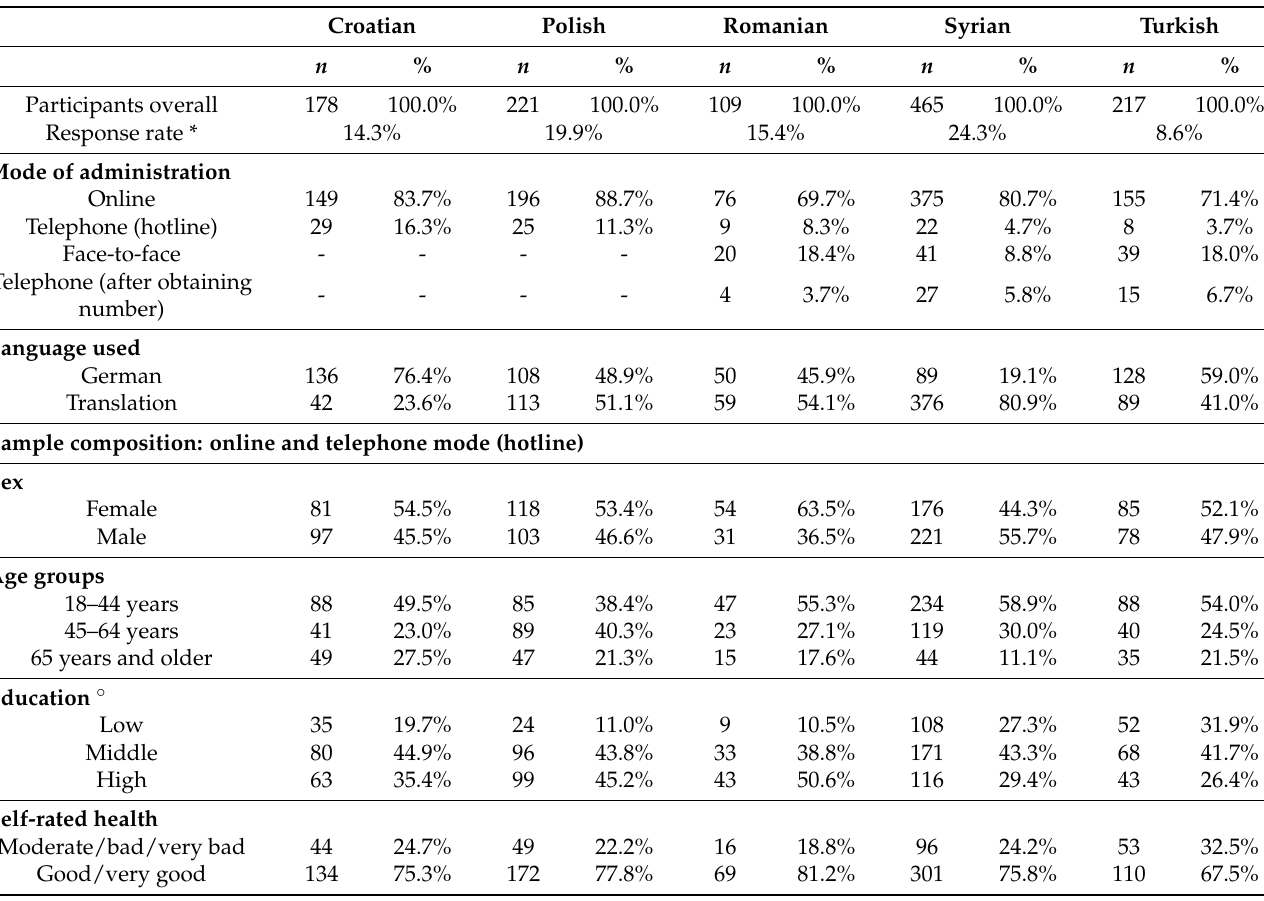
Table 1. Results on participation and sample composition in different administration modes of the IMIRA feasibility study “ Interview Survey ”, n = 1190 participants (adapted from